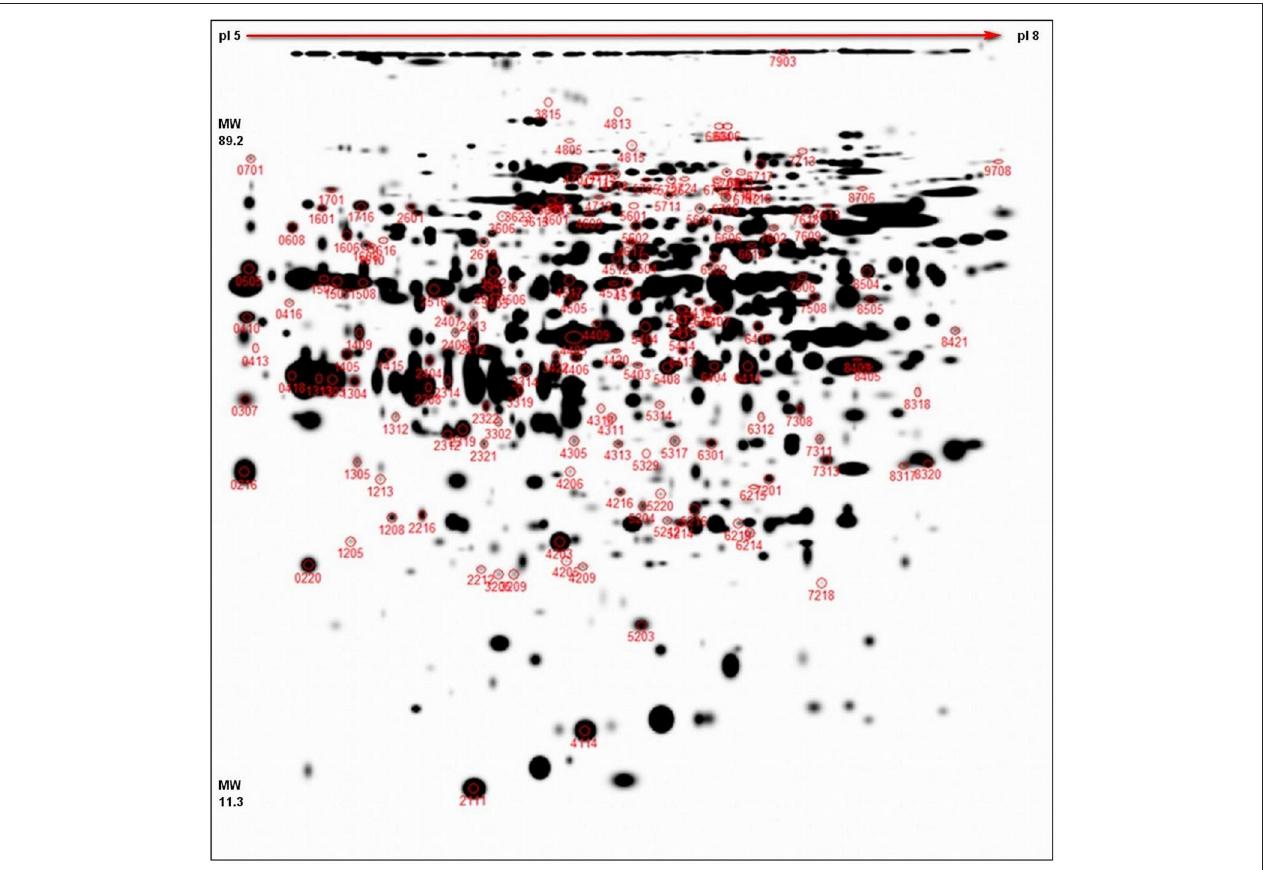
FIGURE 2 | 2D-DIGE representative proteome map. Representative proteome map of total MDE proteins of winter oilseed rape, separated by 2D-DIGE. At least two times up- or down-accumulated proteins ( p < 0.05, 11cm IPG strip, pI 5–8, 1mm thick gel) are marked with the corresponding spot numbers. In total, 156 spots chosen for cutting and identification are shown in red